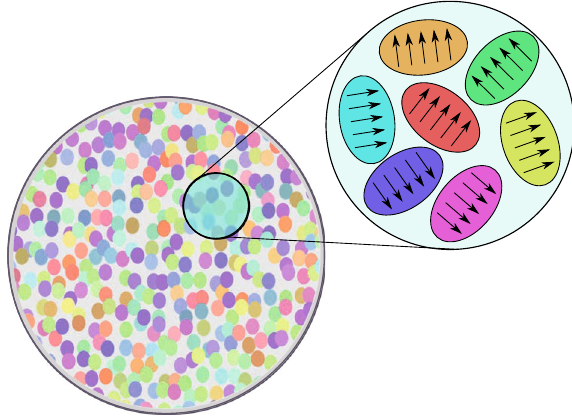
Fig. 3 Picture of the chromoelectric fields inside the